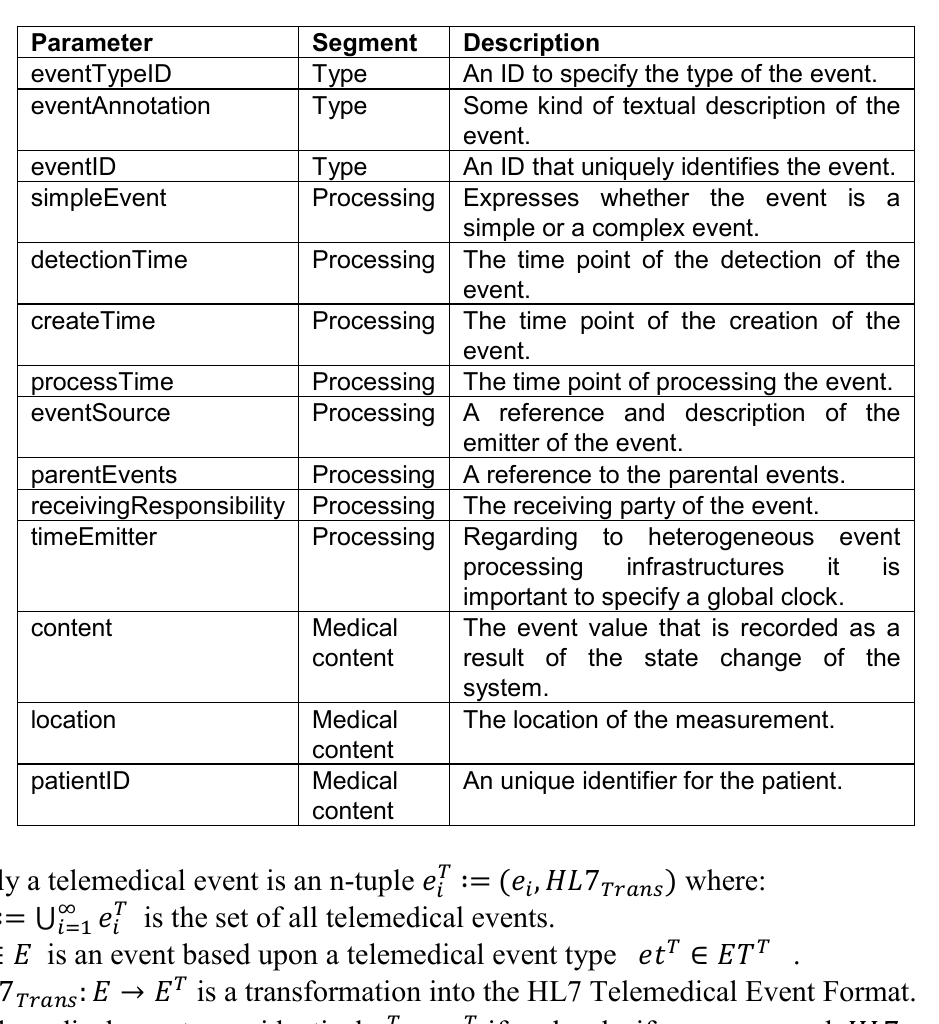
Table 2. Basic attributes which are important for a telemedical event